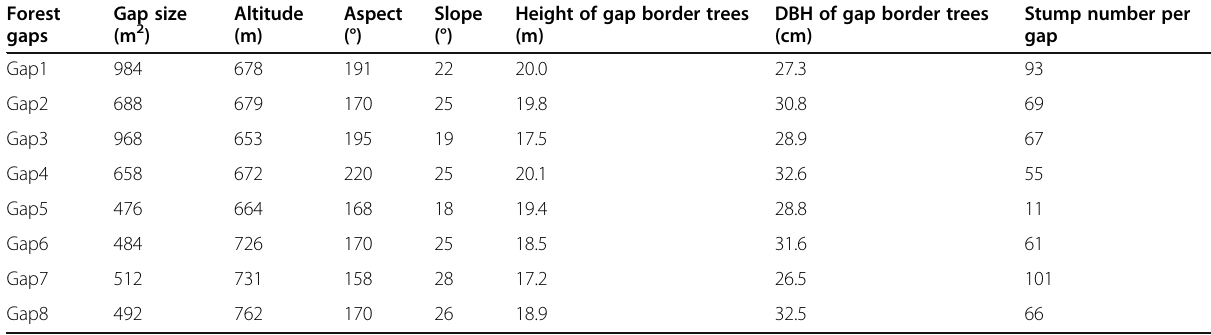
Table 1 Basic description of experimental secondary forest gaps created in March 2015 Forest